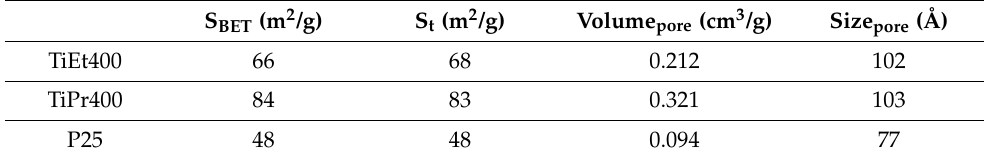
Table 1. Textural parameter values of the calcined samples and TiO2-P25.